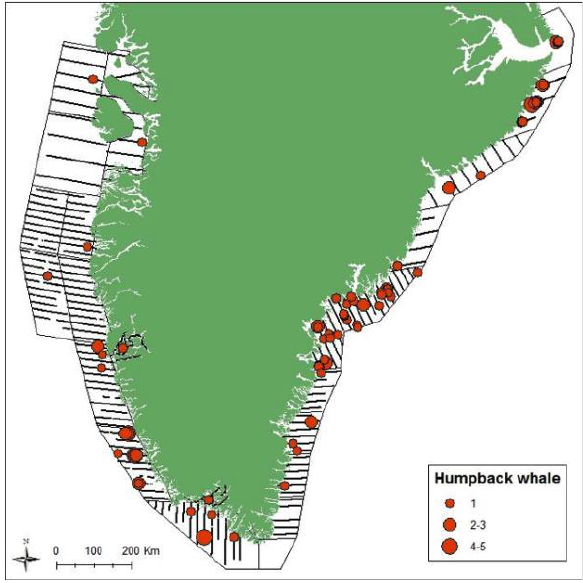
Figure 6. Scaled histograms of perpendicular distances and the predicted detection probability functions for fin whale groups. A) Front observers, B) rear observers, C) both observers and D) pooled detections with sightings fitted to a half-normal model where each observation prediction is shown as a circle. Distance is measured in meters from the line directly below the aircraft.